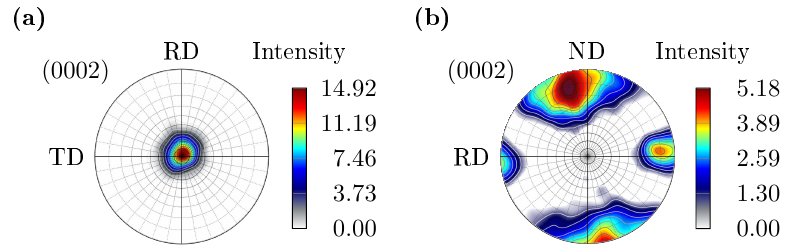
Figure 8. ( 0002 ) pole figures of ( a ) the as-received material with view in the ND [13] and ( b ) the V-bent specimen BS9-003 made of AZ31B after the bending process with view in the TD. Figure 9a shows the gauge area of the structural component BS9-008 with bending radius R BS9 = 9 mm after cyclic loading with a force amplitude of F a = 1104 N and a force ratio of R F = 1. The specimens were removed from the testing machine in such −